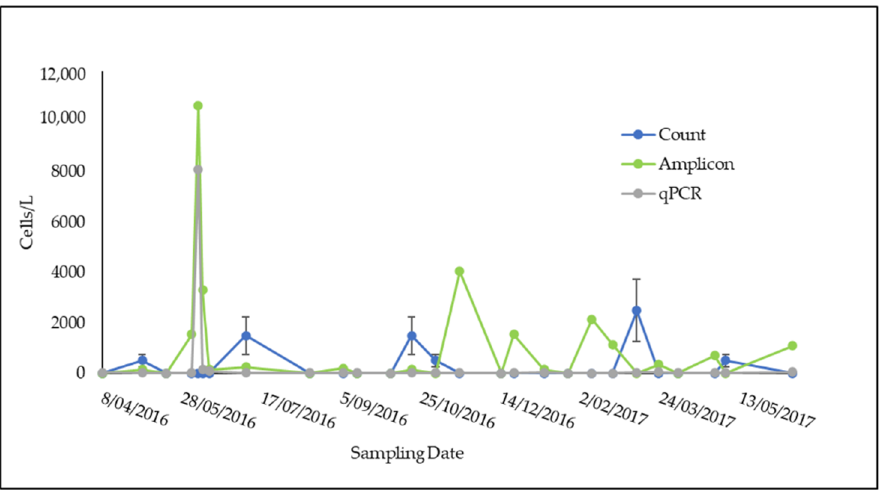
Figure 3. Towra Point P. minimum cell counts L − 1 with amplicon sequencing, qPCR, and microscope counts across the BPA sampling period. Standard error bars are included for qPCR (too small to detect) and count data.